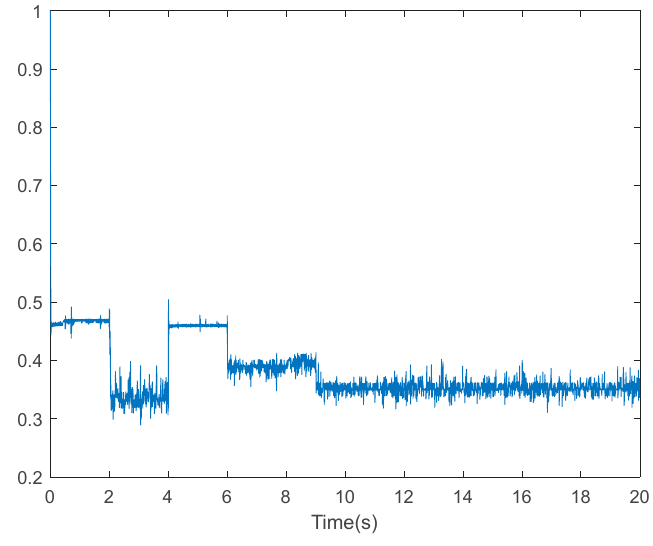
Figure 17. Controller signal.